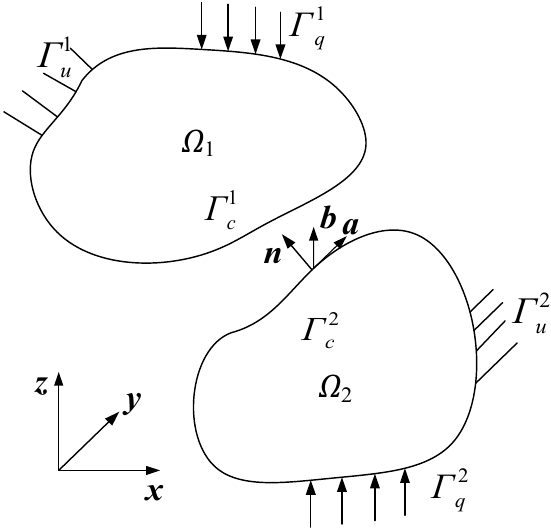
Figure 1. A sketch of the contact problem. The basic equations of static friction contact problems in incremental form can be expressed as: